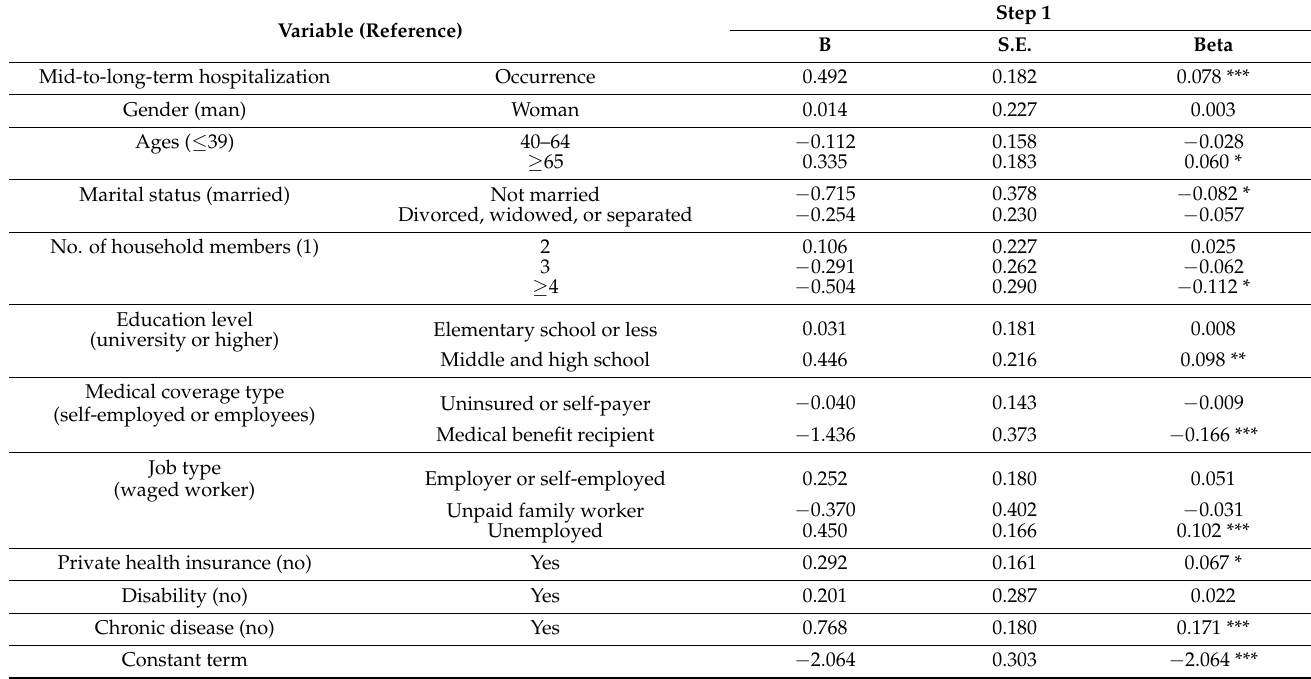
Table 3. The effect of MLTH on CHE (Model 1).